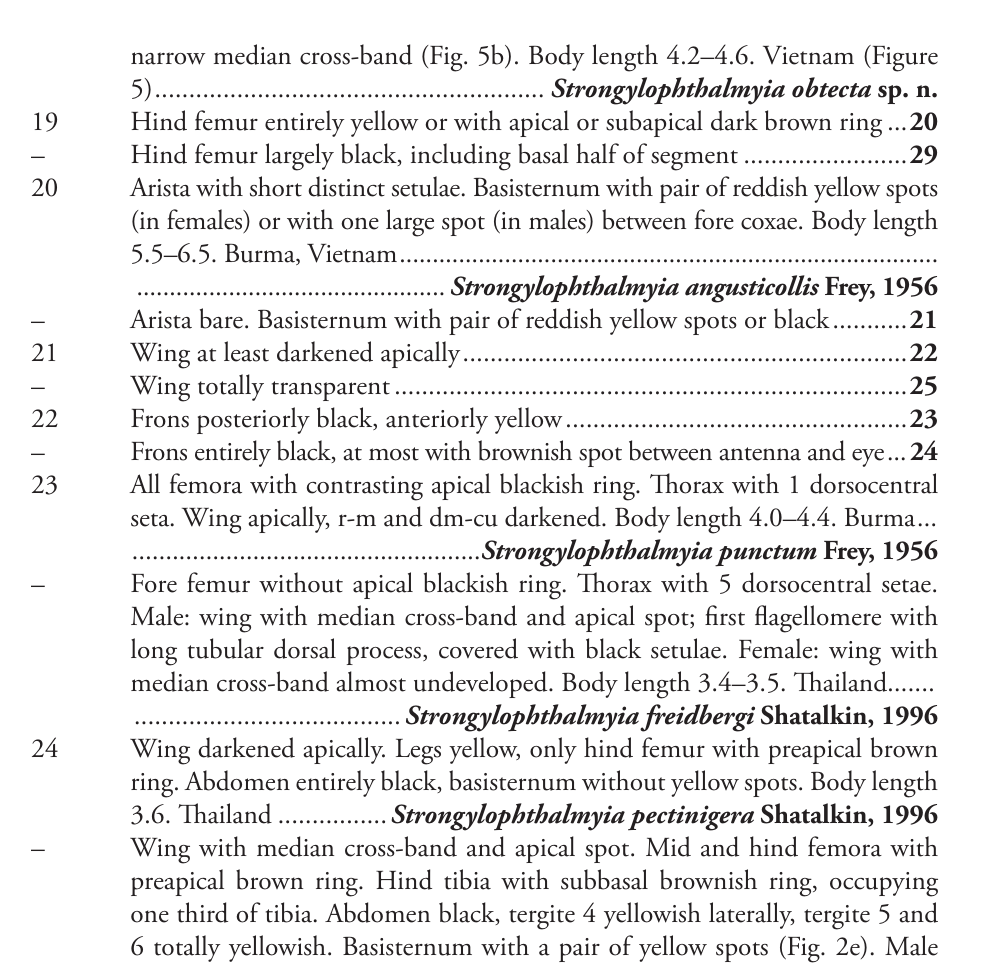
– 26 Smaller: Male (female unknown) body length 2.3. Hind tibia yellow, brownish in middle. Male: first flagellomere with short conical process (Shatalkin 1996, Fig. 27). Thailand, Vietnam ................................................ – Larger: Body length 3.5–4.5. Hind tibia yellow or brownish basally. First flagellomere normal in male and female .................................................... 27 27 Proximal section of M restricting discal cell before r-m approximately 0.5– 1+2 0.6 times as short as distal section. Male palpus (Shatalkin 1996, Fig.